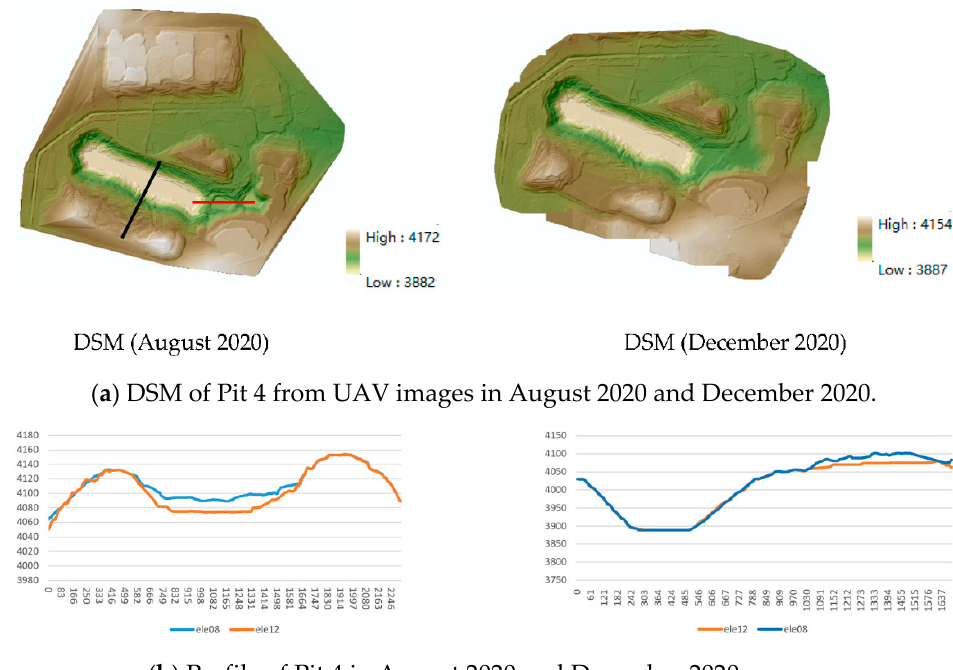
Figure 3. DSM and profile of Pit 4 in August 2020 and December 2020.